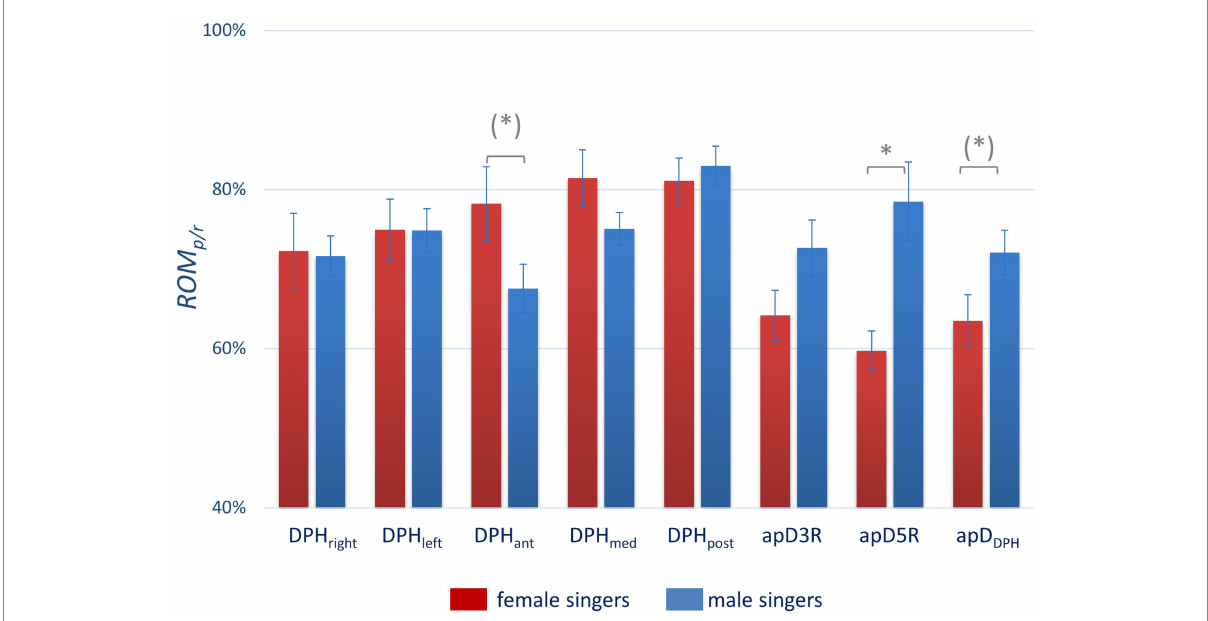
FIGURE 6 Significantly more thoracic movement in male and a tendency to more diaphragmatic movement in female subjects during maximal sustained phonation in relation to vital capacity respiration. The figure compares the phonatory movement range in relation to the respiratory movement range (ROM p/r ) for male (blue) and female singers (red) for different locations. Significant differences are marked with *( p = <0.05) and tendencies with (* p = <0.10). All p-values are displayed in Table